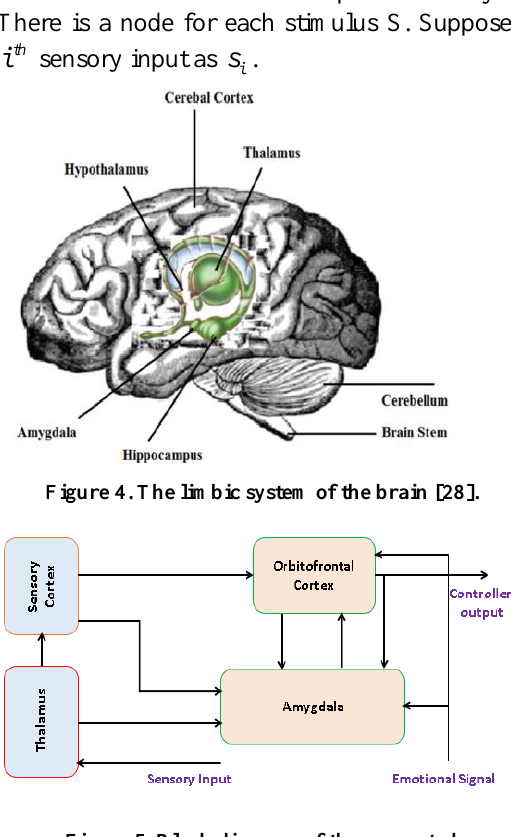
Figure 5. Block diagram of the presented computational model of human brain learning mechanism.